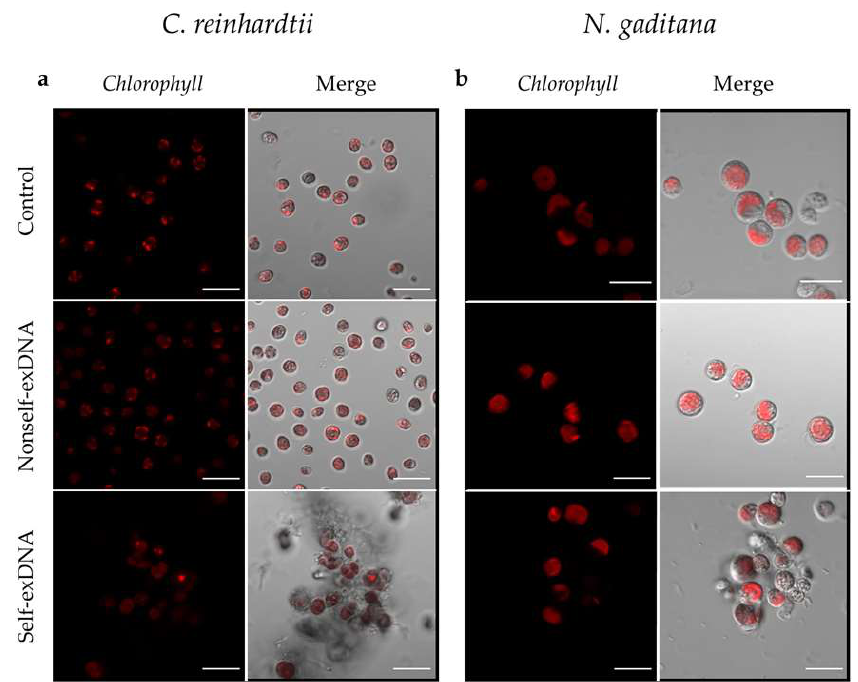
Figure 2. Microscopy analysis of C. reinhardtii ( a ) and N. gaditana ( b ) samples in controls and after treatments with nonself- and self-exDNA at 30 ng/µL. In red, the chlorophyll autofluorescence is shown (Ex/Em 1 : 405/300–800); the composite is also shown (Merge). Microscope: Zeiss LSM 700, Oberkochen, Germany Excitation at 405, detection in the range 300–800, Objective: 63× 1.40 Oil Dic. 1 Ex/Em = Excitation/Emission. In order to investigate the nature of cellular aggregates and extracellular matrices observed after the treatment with self-exDNA at 30 ng/µL, we stained the aggregates formed in both species with DAPI (Supplementary Figure S3). The dye remarked the localization of DNA in the cell nucleus and in the organelles (plastids and mitochondria) in both control cells, and cells treated with both self- and nonself-exDNA. Moreover, in the self-exDNA treatments, the dye also stained all heteromorphous aggregates including the extracellular matrices, which were instead absent in nonself-exDNA treatments and in the control.